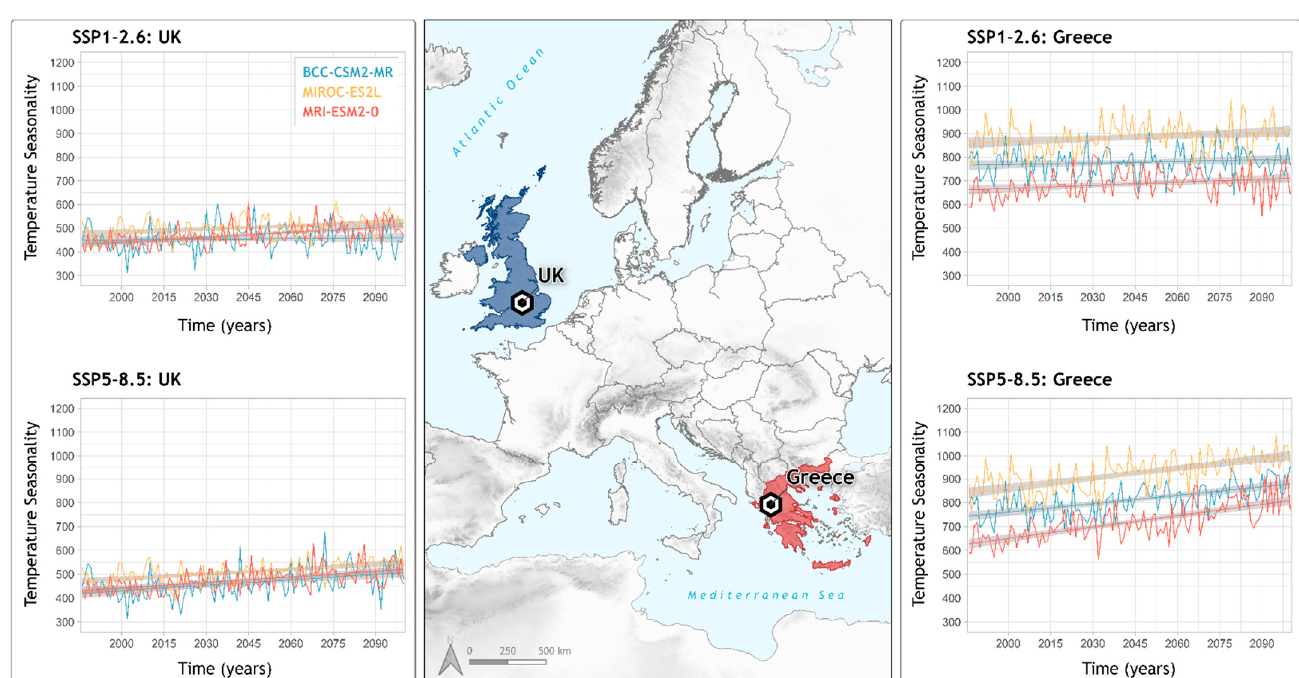
Figure 5. Temperature seasonality variation for two selected locations of Ophrys insectifera distribution over the time period 1986–2100. UK (in blue) represents an area of range gain, while Greece (in red) an area of range loss. Two shared socioeconomic pathways (SSPs) are presented, as best-case and worst-case scenarios (SSP1-2.6 and SSP5-8.5, respectively). In all panels, each line represents a global circulation model (GCM): BCC-CSM2-MR (cyan line); MIROC-ES2L (yellow line); MRI-ESM2-0 (coral red line).